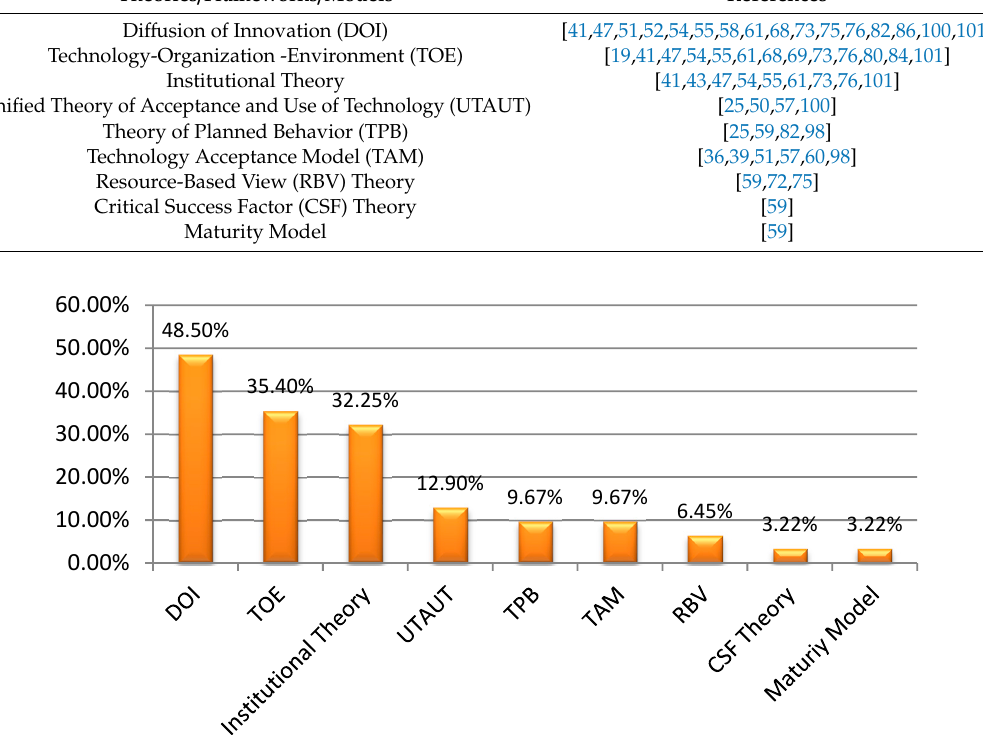
Figure 6. Theories and frameworks/models used for BIS adoption/acceptance.